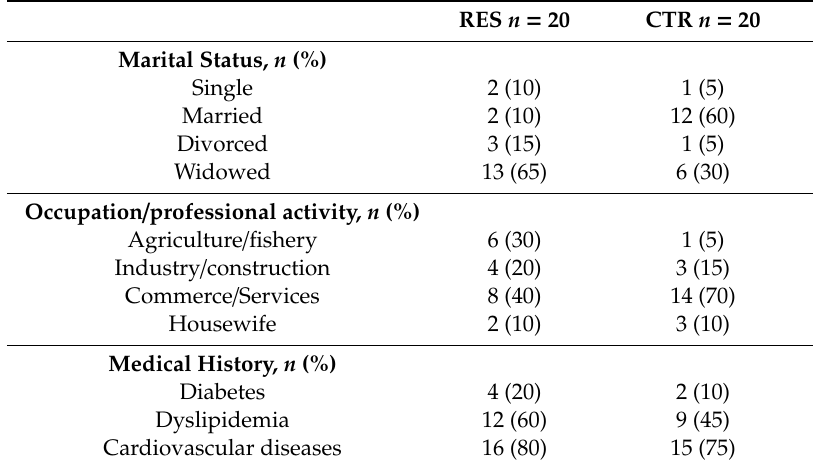
Table 1. Descriptive statistics of the total sample in terms of marital status, occupation / professional activity, and medical history, discriminated by